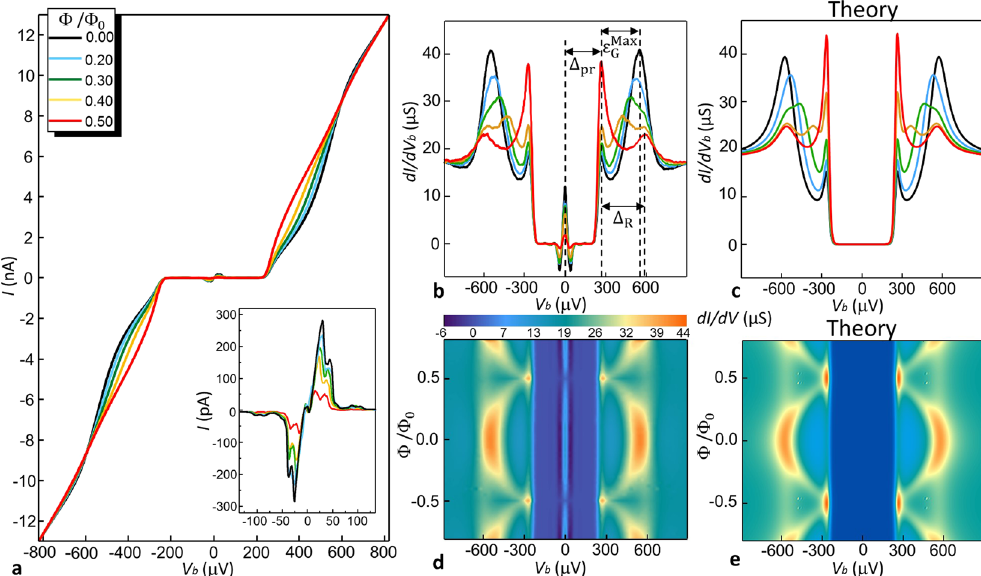
Figure 2. Interferometer characterization at T bath = 25 mK (sample-A). ( a ) Current-voltage I ( V b ) characteristics measured for some values of the flux Φ generated by the external magnetic field. Inset: enlargement around zero bias of the I ( V b ) characteristics. The peak around zero bias, with maximum magnitude  I 280 pA, is the Josephson current flowing through the superconducting probe junction. ( b ) Measured and ( c ) theoretical differential conductance as function of voltage bias for Φ values as in ( a ). ( d ) Experimental and ( e ) theoretical color plot of the differential conductance dI / dV versus voltage and magnetic